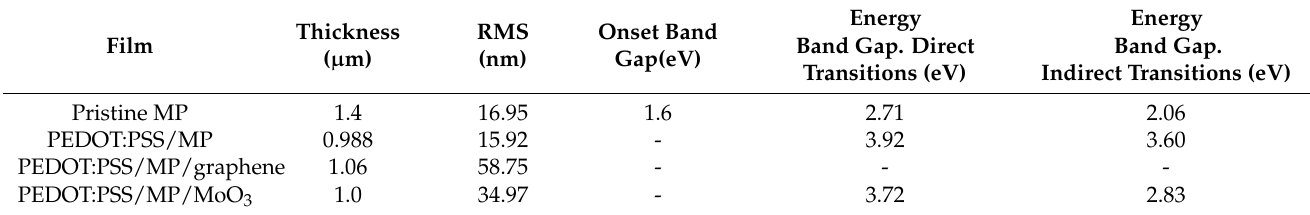
Table 1. Rugosity and optical parameters for the films based in MP.